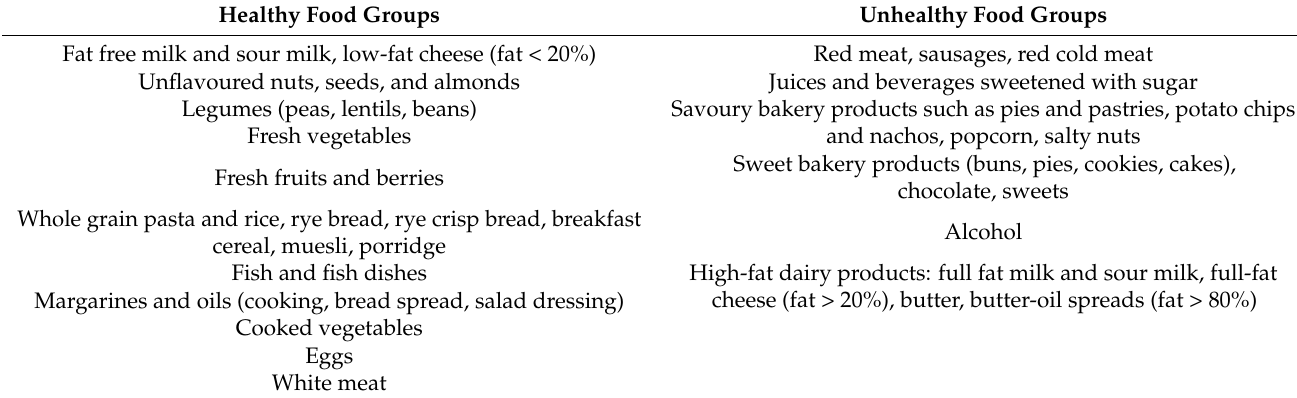
Table 1. Food groups considered healthy or unhealthy, based on the Nordic Nutrition Recommenda- tions (Section 5; Food, food patterns and health outcomes—Guidelines for a healthy diet) [39] and on previous scientific understanding about the association between diet and cognitive health